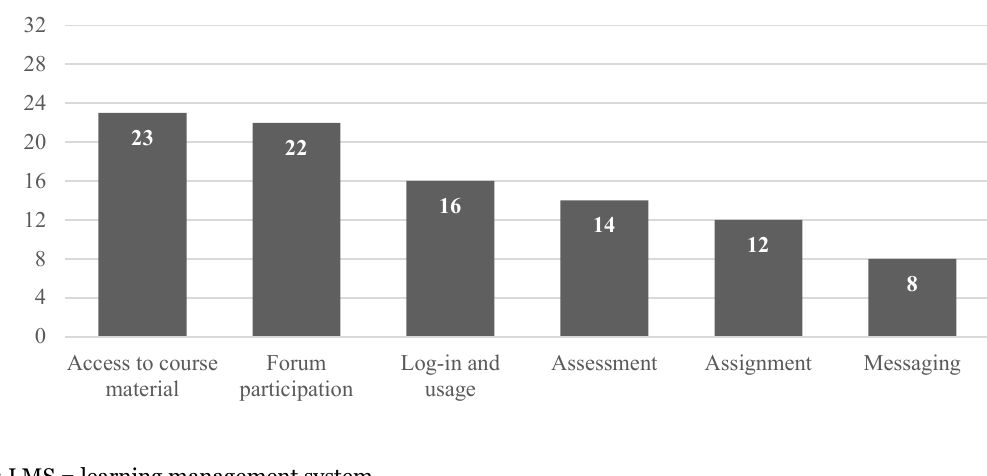
Note : LMS = learning management system.